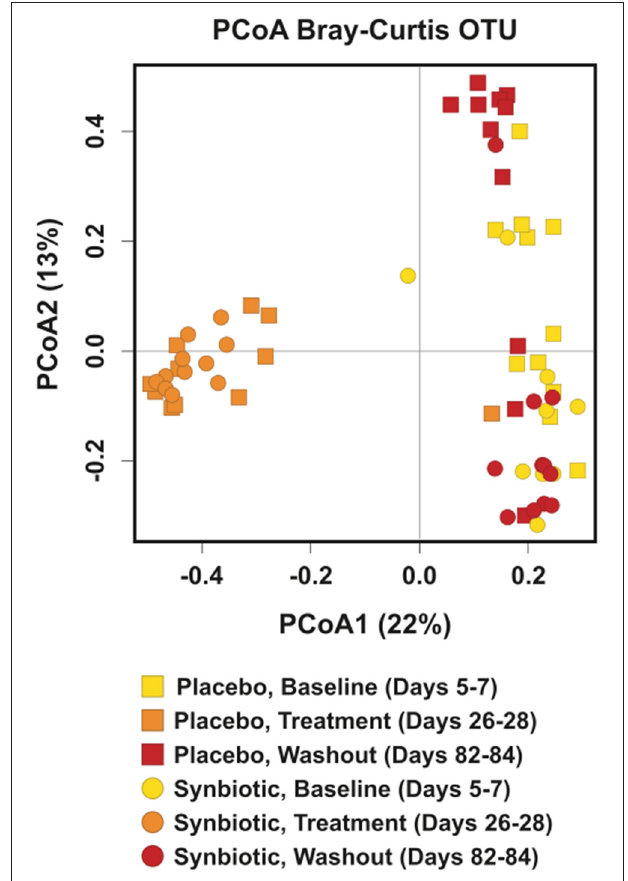
FIGURE 2 | Principal Coordinate Analysis (PCoA) of unweighted UniFrac distances of 16S rRNA genes for dogs that received enrofloxacin/ metronidazole followed by placebo or synbiotic for 21 days. Gene sequences were determined using fecal samples collected at the conclusion of baseline (days 5–7), antibiotic administration (days 26–28), and a 56-day washout (days 82–84) from 22 healthy dogs, 11 per group, + that received enrofloxacin (10 mg/kg qd) and metronidazole (12.5 mg/kg BID), followed 1h later by placebo or a synbiotic combination (BID) PO for 21 days. + Feces from one dog (placebo group) unavailable at the days 26–28 time